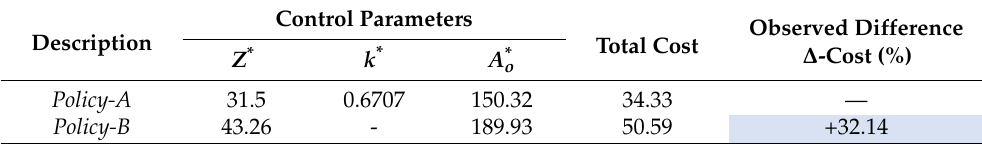
Table 10. Policy Comparison.